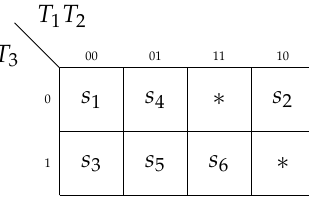
Figure 5. Outcome of state maximum binary state